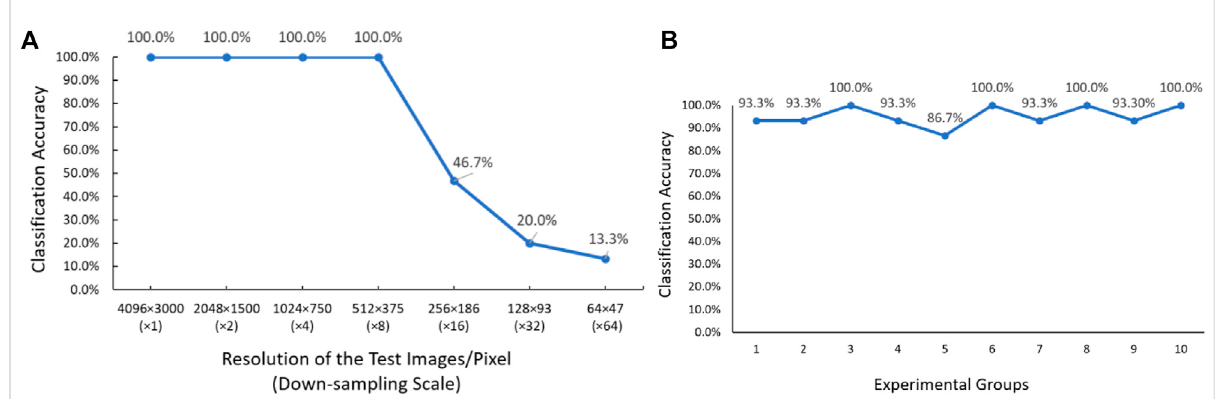
FIGURE 12 The accuracy and the loss the in fl uence of image resolution on the classi fi cation results (A) and the in fl uence of the change of image fi eld of view on the classi fi cation results (B)